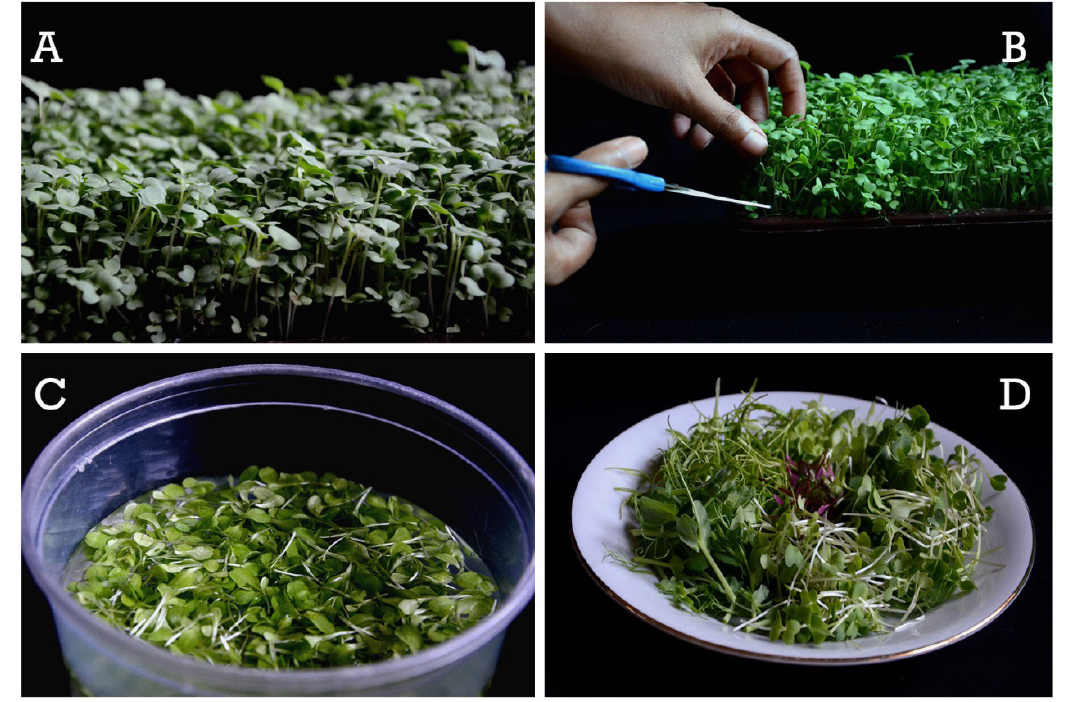
Figure 1: Steps involved in preparation of microgreen salads, A: microgreen at harvesting stage, B: harvesting microgreens, C: washing to remove plant debris and seed coat, D: Microgreen salad